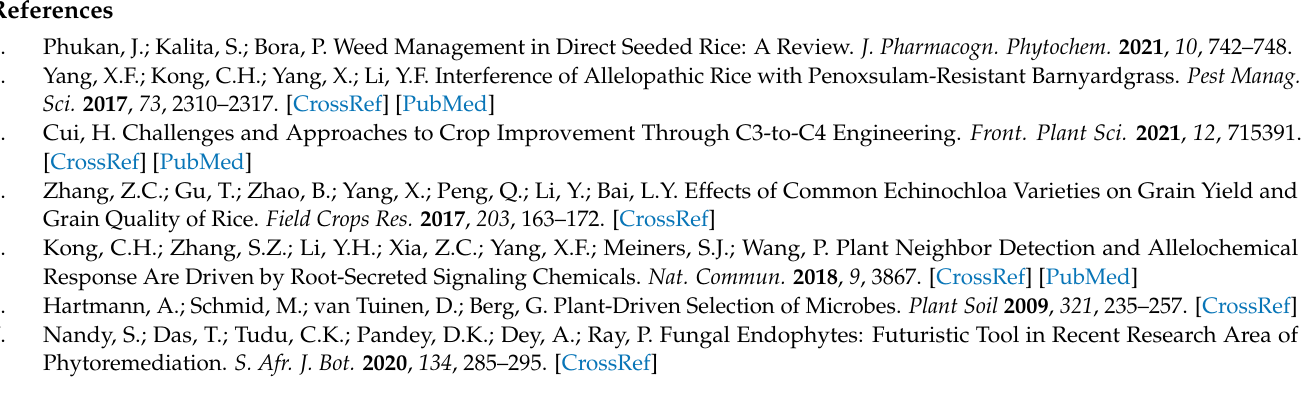
groups. Table S5: The vital fungi in rice groups. Table S6: The vital bacteria in barnyardgrass groups. Table S7: The vital fungi in barnyardgrass